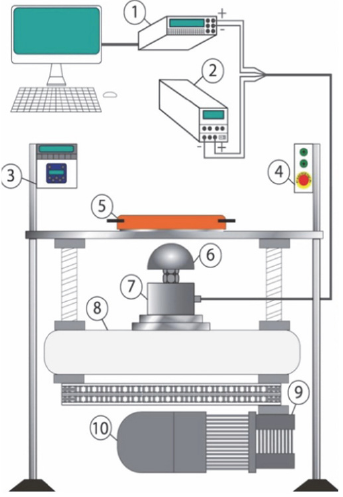
Figure 2. Machine used for the forming tests: ➀ multimeter; ➁ power supply; ➂ interface for the test parameters management; ➃ control panel for the punch translation; ➄ die-drawbead component; ➅ punch; ➆ load cell; ➇ crosshead; ➈ rotating screw jack; ➉ electric motor.